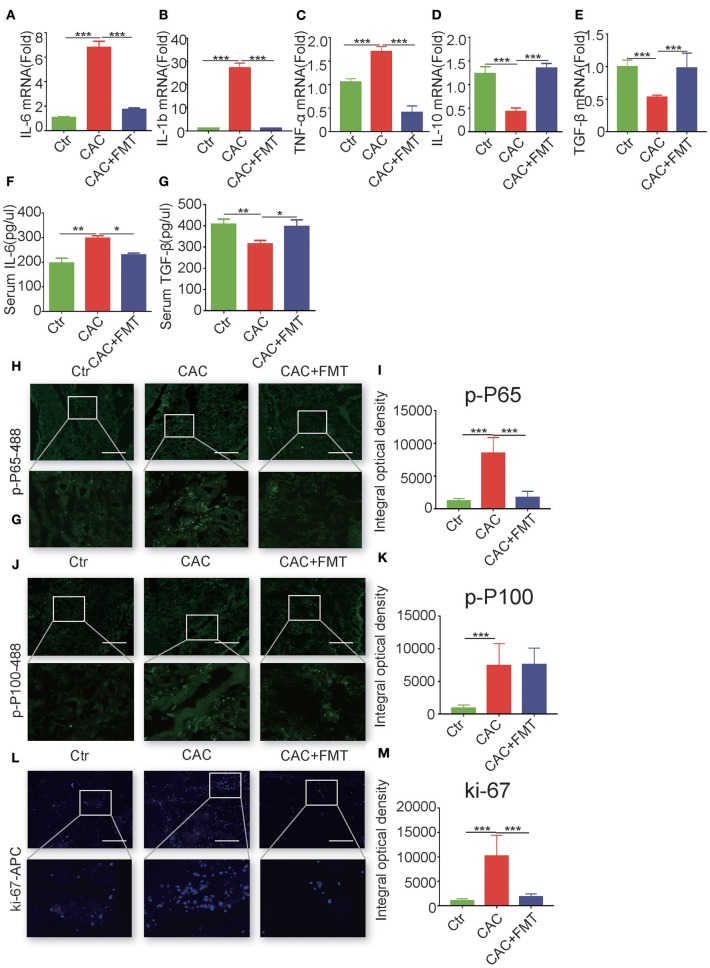
Fecal microbiota transplantation (FMT) downregulates pro-inflammatory cytokines and promote anti-inflammatory responses and inhibits nuclear factor (NF)-κB activity and cellular proliferation. (A–E) Real-time RT-PCR analysis of interleukin (IL)-6 (A), IL-1β (B), tumor necrosis factor (TNF)-α (C), IL-10 (D), transforming growth factor (TGF)-β1 (E) in colon tumor tissue of each group; results are presented using the 2—ΔΔCt method (ANOVA/LSD). (F,G) Concentration of serum cytokines TGF-β and IL-6 analyzed by ELISA at day 70 after being injected with azoxymethane (AOM) (ANOVA/LSD). Immunofluorescence of Pho-p65 (H), pho-p100 (J), or Ki67 (L) in the colon tissue from CAC mice treated with or without FMT. Original magnification, ×200. Bars in white represent size of 50 μm (20 μm for mid row). The mean optical density of Pho-p65 (I), Pho-p100 (K), or Ki67 (M) positive cells from 10 random fields in each mouse was digitized and analyzed on Image-Pro Plus software. Data are expressed as the mean ± SD of six mice for each group, and the experiments were repeated three times with similar results. *P < 0.05, **P < 0.01, ***P < 0.001.